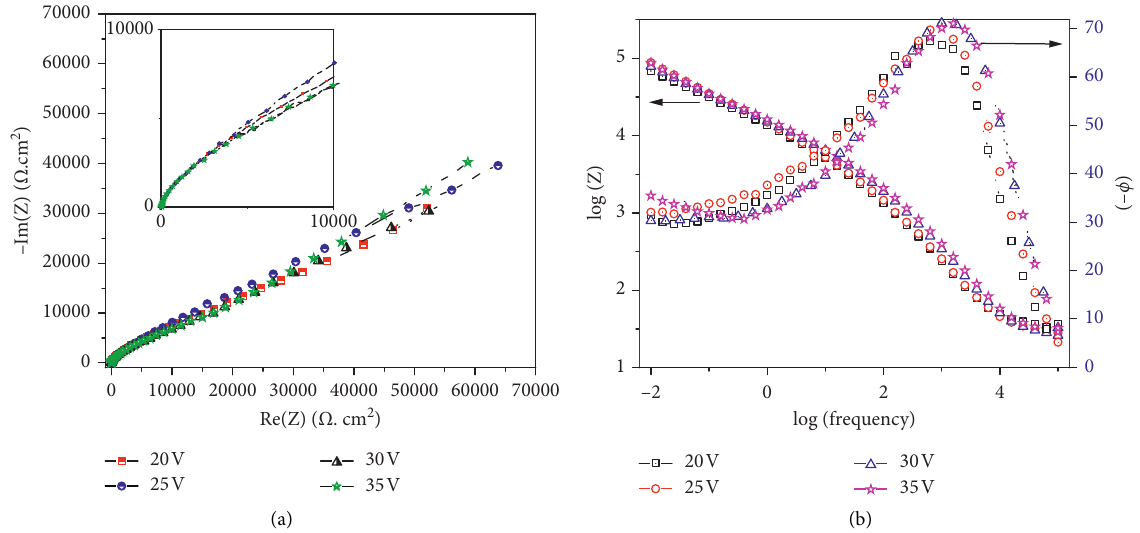
Figure 10: Electrochemical impedance spectroscopy of anodized samples, obtained in 10 − 1 M of Na sentation; (b) Bode